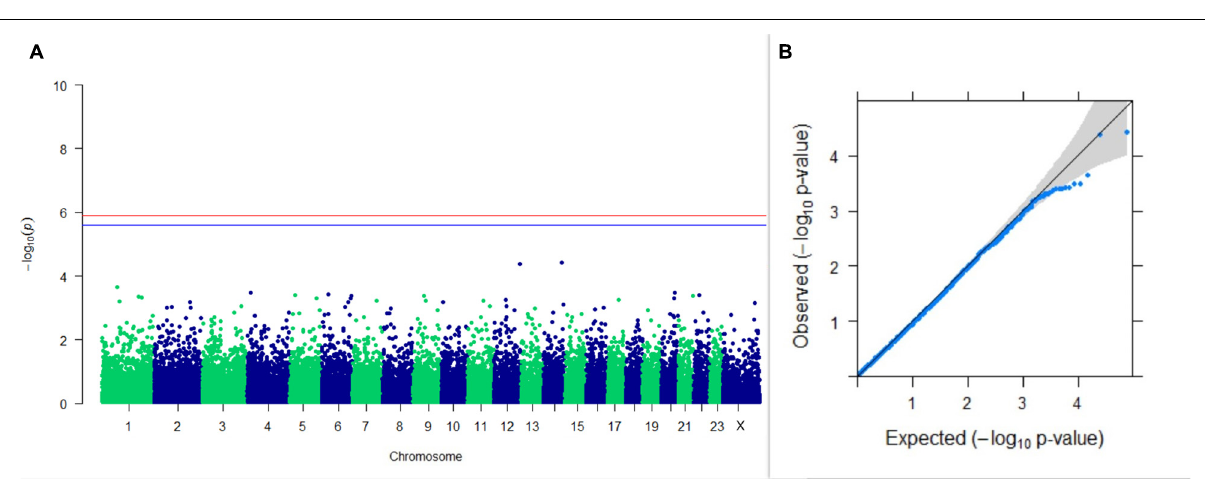
FIGURE 6 | Results of GWAS for PC2 of the test day’s SNF percentage. (A) Manhattan plot of genome-wide SNPs. The red line indicates the p- value threshold (expressed as –log 10 P ) corresponding to FDR-corrected p- values or q = 0.05, above which the SNPs are considered to be significantly associated with the trait, while the blue line indicates the genome-wide suggestive threshold at q = 0.1. The SNPs identified on chromosome no. 24 were screened out from analysis because of stringent quality control; hence, it is not represented in the Manhattan plot. (B) Q-Q plot of the p-